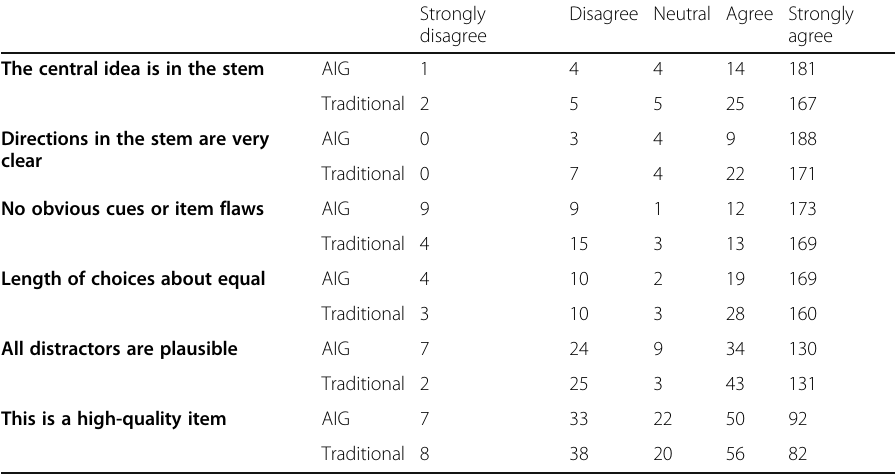
Table 3 Frequency distributions for item quality metrics by item modality